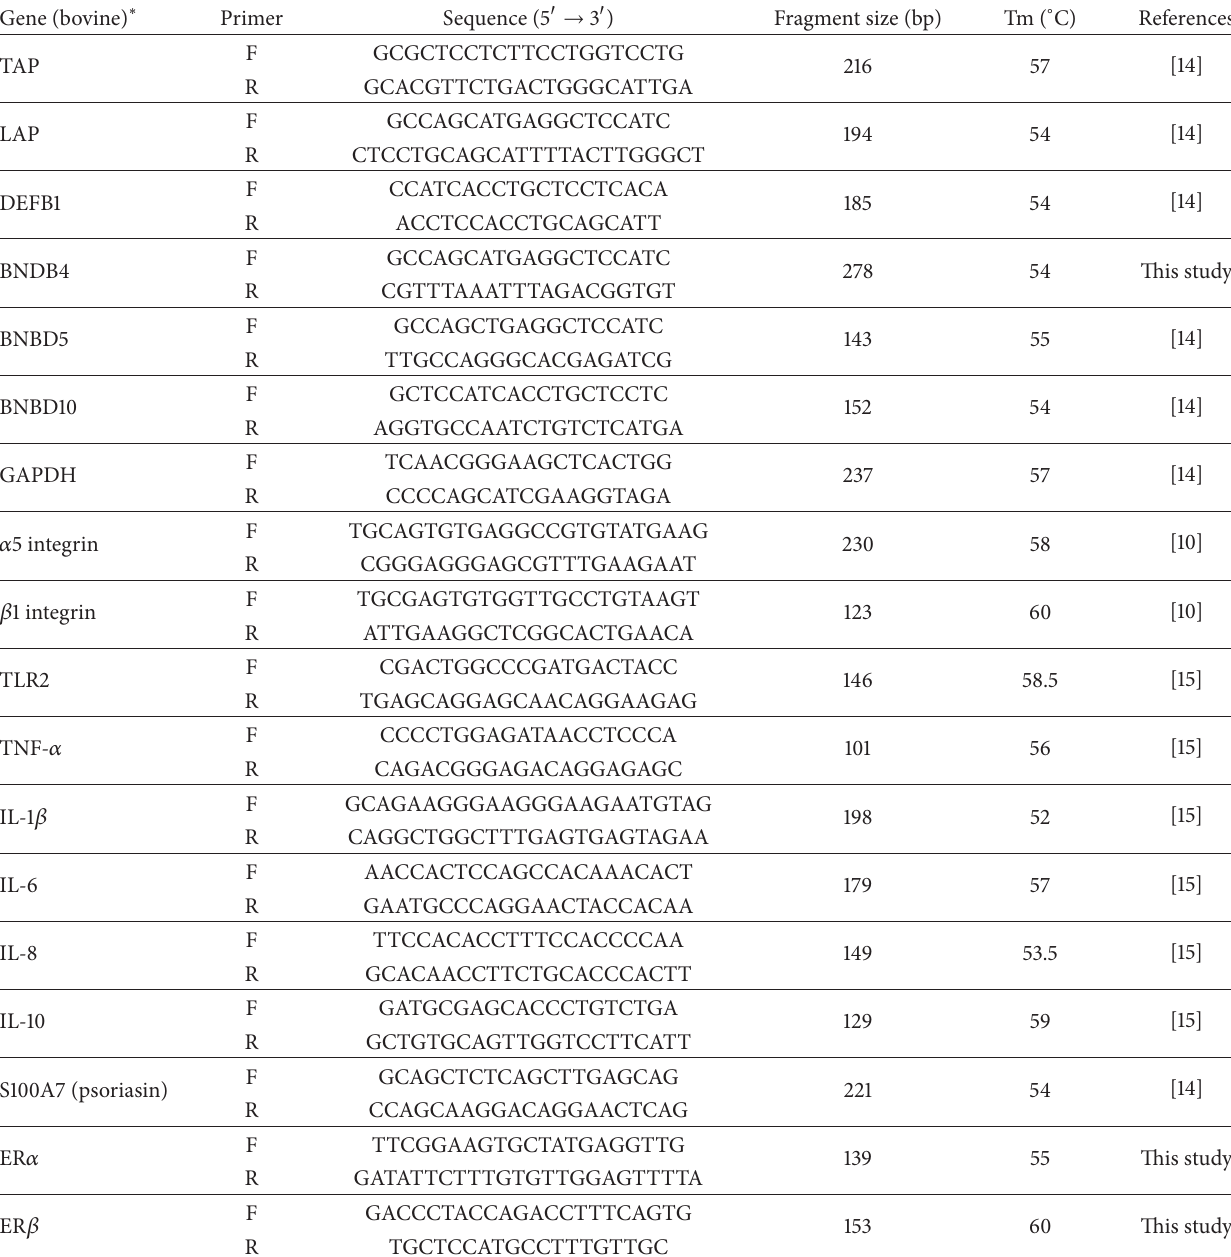
Table 1: Oligonucleotides used in this